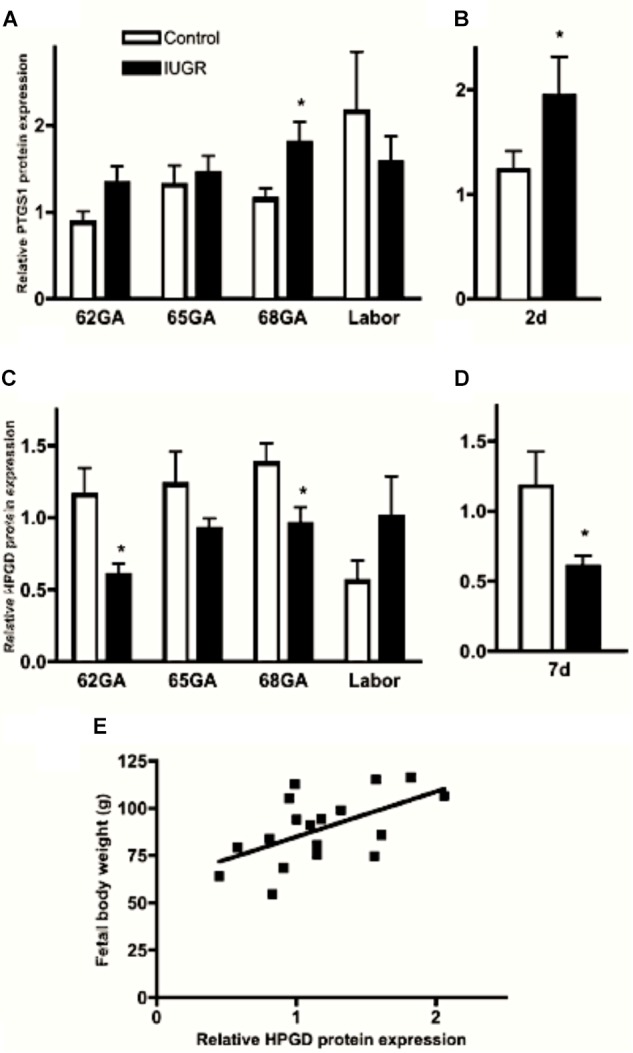
Myometrial PTGS1 (A,B) and visceral yolk sac membrane HPGD (C,D) protein expression in control (open bars) and IUGR (closed bars) guinea pig pregnancies over late gestation and 2 (B) and 7 (D) days prior to expected delivery. ∗P < 0.05 IUGR vs. control. Significant positive correlation between fetal body weight and visceral yolk sac membrane HPGD levels at GA68 (E; r = 0.56, P = 0.015). Adapted with permission from Palliser et al. (2014).